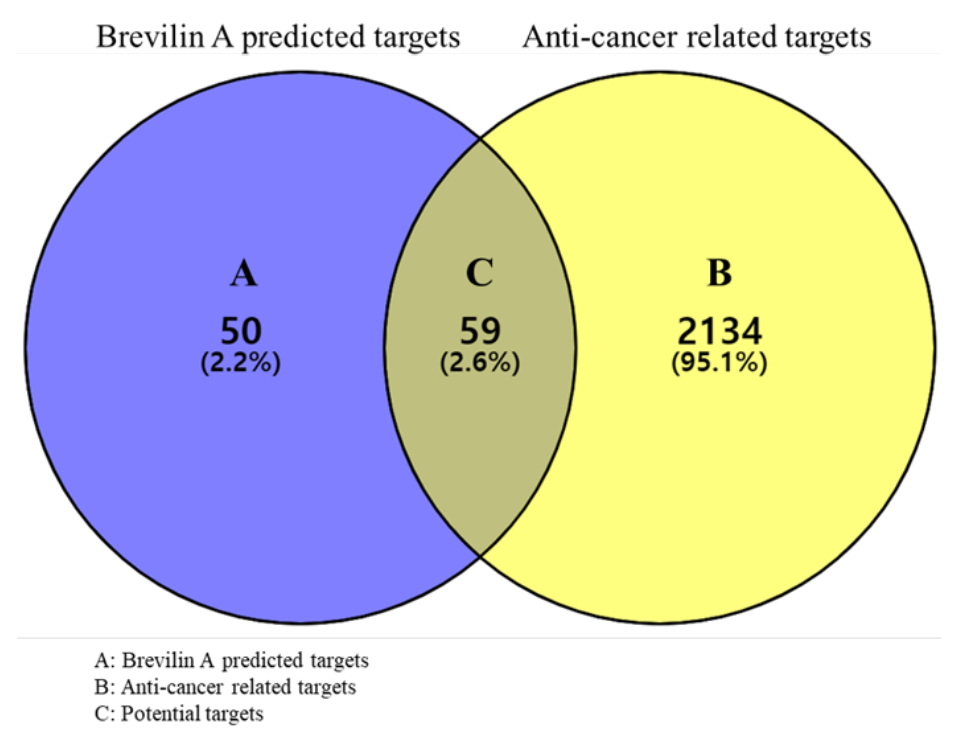
Figure 1. A Venn diagram of brevilin A predicted targets and anticancer-related targets. Table 1. A list of potential brevilin A predicted/anticancer-related targets.